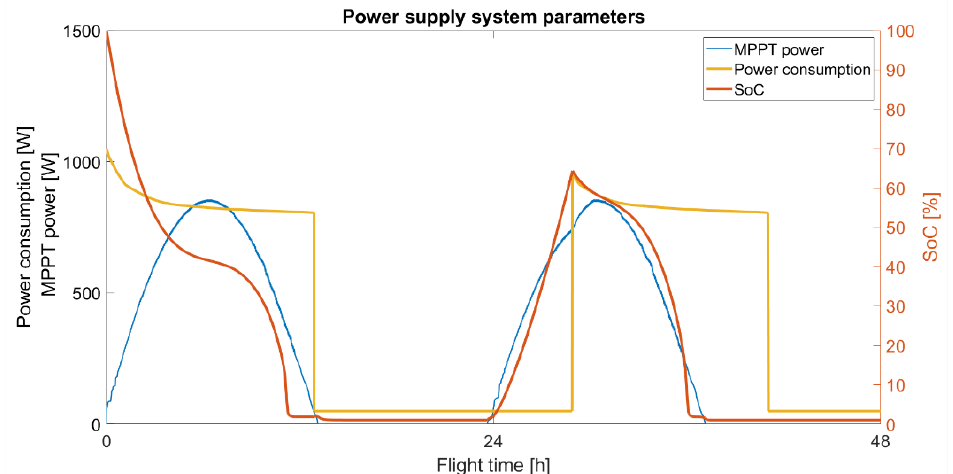
Figure 29. TwinStratos 12 20 km scenario in the vernal equinox.